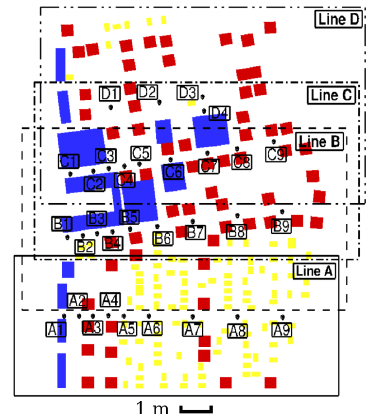
Figure 5. Top view and side view of the basin.